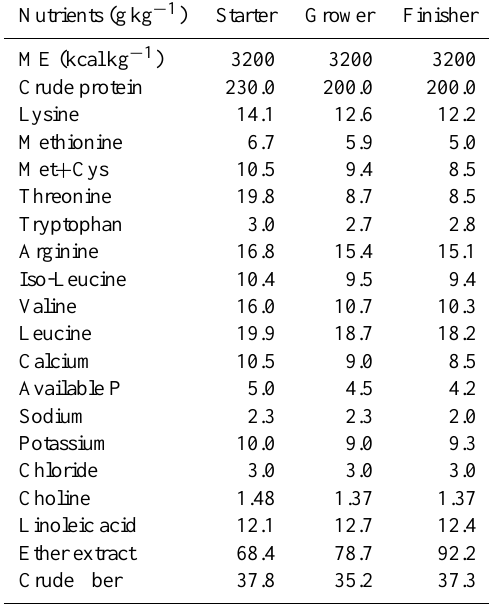
Table 1. Ingredient composition of diets fed to broilers during the experimental period.